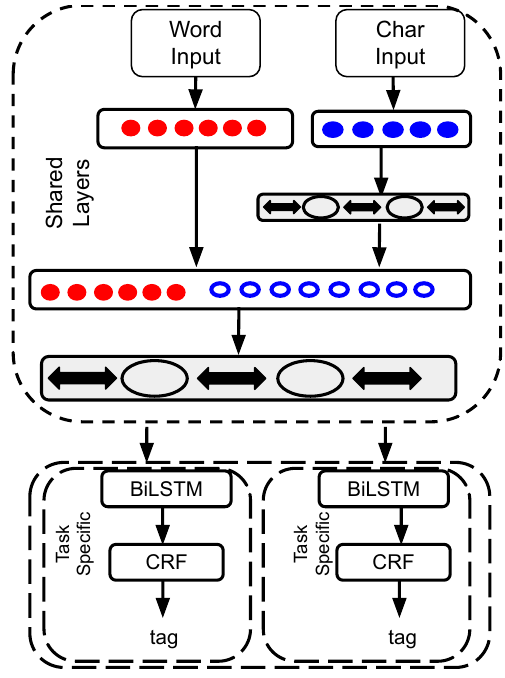
Figure 5. Our proposed model used for fine-tuning ( MTM → STM